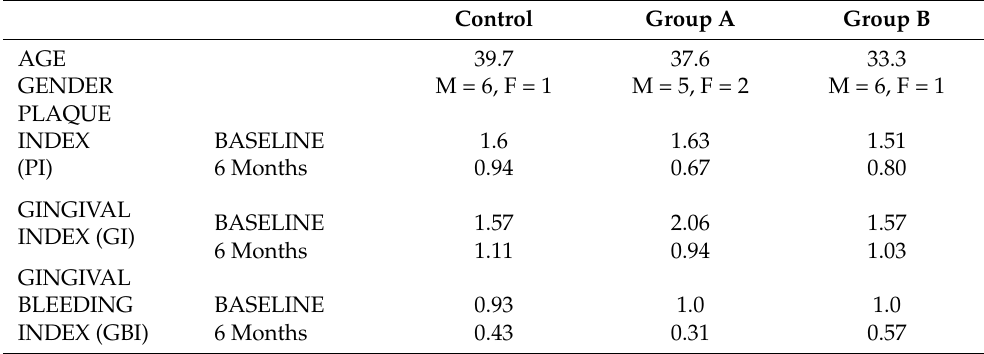
Table 1. Showing mean values of demographic characteristics and PI, GI and GBI at baseline and 6 months in control, group A and group